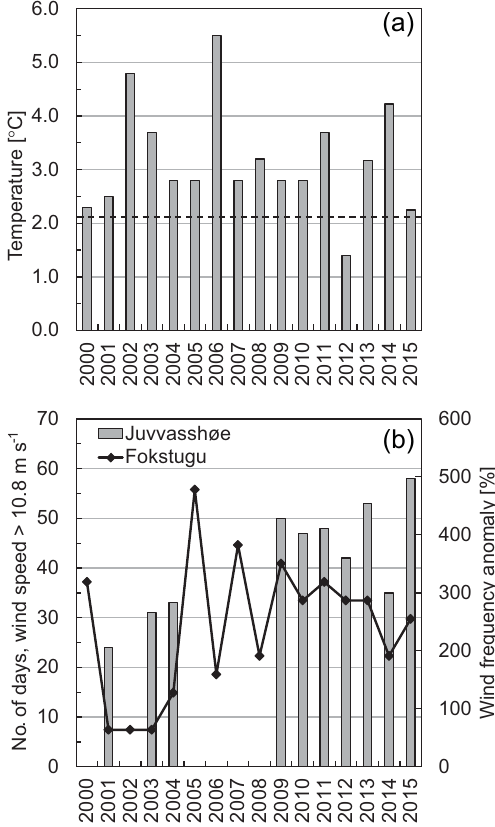
(750m from the front of Juvfonne) and Fokstugu 70km NE (a) Juvvasshøe June–September mean air temperature. The black dot- ted line denotes the 1971–2000 mean, obtained from the interpo- lated seNorge dataset (Engeset et al. 2004). (b) Number of days for the period June–September with strong breeze or higher (wind speed above 10.8ms − 1 ) at Juvvasshøe (grey bars) and at Fokstugu (black line), the latter shown as anomaly (in %, right axes) with respect to 1971–2000